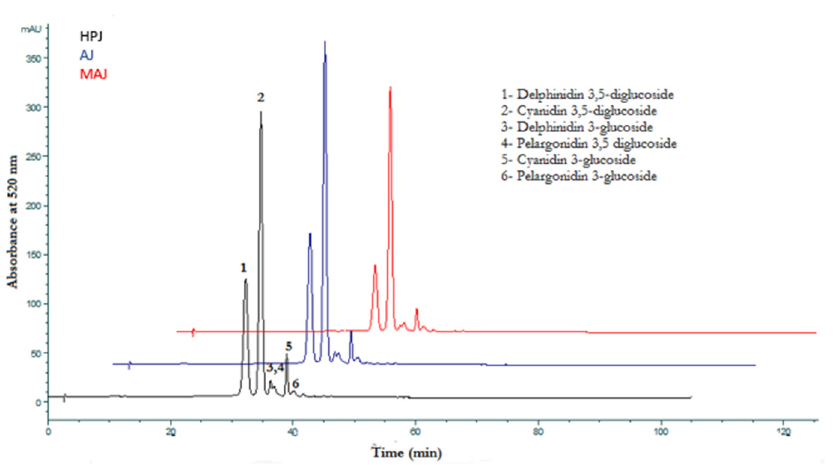
Figure 1. HPLC chromatograms of anthocyanins identified in pomegranate juice samples. (AJ—Arils juice, HPJ—halved pomegranate juice, MAJ—macerated arils